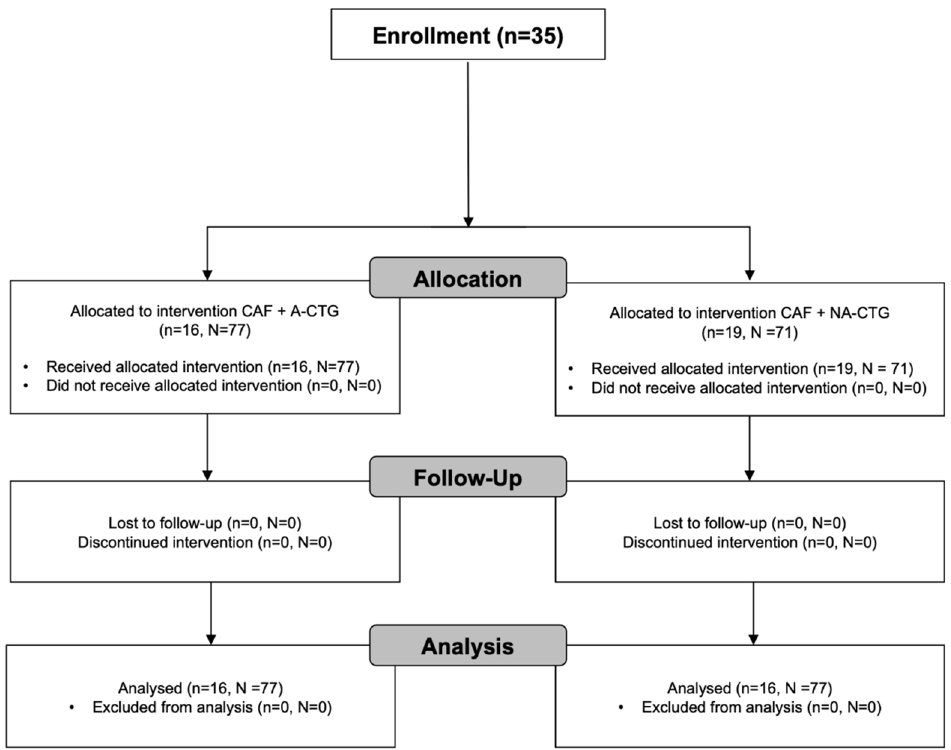
Figure 1. Consort flowchart of the study CAF, coronally advanced flap; A − CTG, augmented connective tissue graft; NA − CTG, nonaugmented connective tissue graft; n—number of subjects, N—number of gingival recessions.